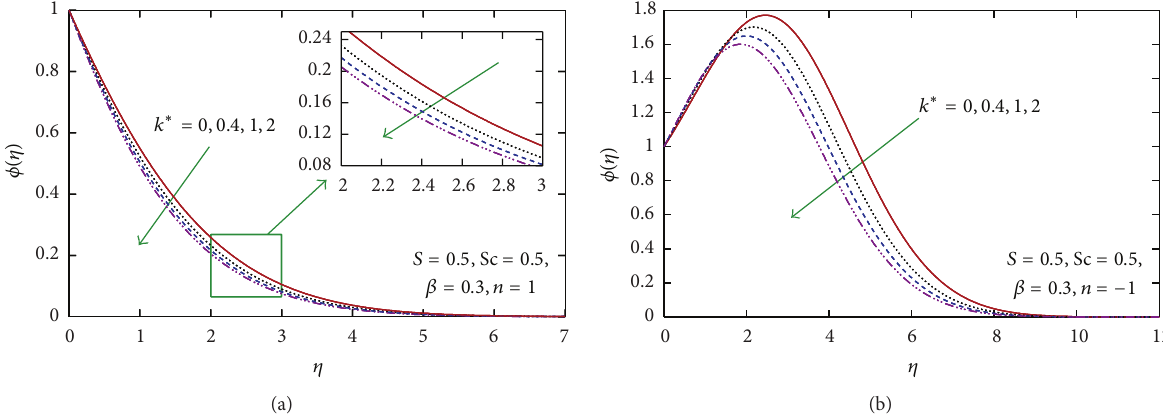
Figure 3: (a) Concentration profiles 𝜙(𝜂) for different values of 𝑘 ∗ with 𝑛 > 0 . (b) Concentration profiles 𝜙(𝜂) for different values of 𝑘 ∗ with 𝑛 < 0 .